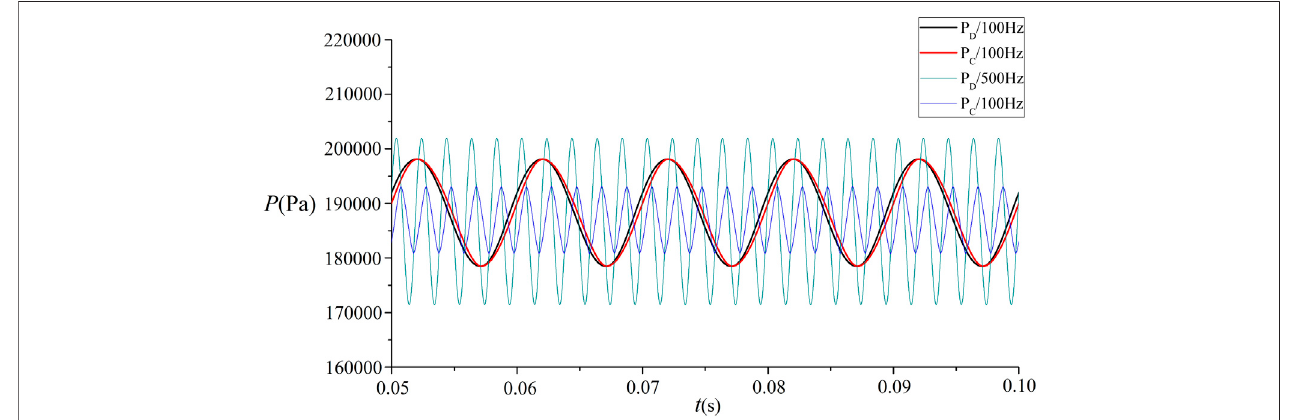
FIGURE 8 | Pressure comparisons under different back pressure variation